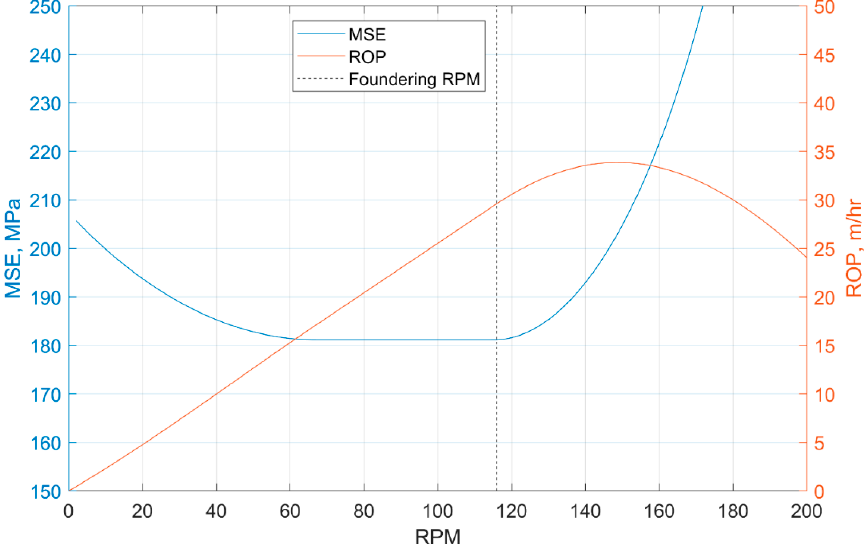
Figure 5. MSE and ROP as functions of RPM , illustrated for a constant WOB value of 10,000 kg. A contour plot detailing how the MSE varies as a function of applied WOB and RPM is shown in Figure 6. This plot is generated using the proposed extended model, where the ROP is penalized when drilling in the three dysfunction regions (as shown in Figure 2). As can be seen in Figure 6, there is a region around the point at which the WOB value is approximately 12,900 kg and the RPM value is 90, where one would drill with the minimal MSE value of 180 MPa. This point corresponds to the top corner of the optimum zone depicted in Figure 2. Moving away from this low MSE region in any direction will increase the MSE ; at first with small values and then progressively larger values as we move into the different dysfunction regions where drilling is less efficient. Comparing Figures 6 and 3b, it can also be observed that the highest possible ROP values which are found in the region around a WOB of 14,000 and an RPM of 120, correspond to drilling with a dysfunction, as is reflected by the higher MSE values around this point in Figure 6.